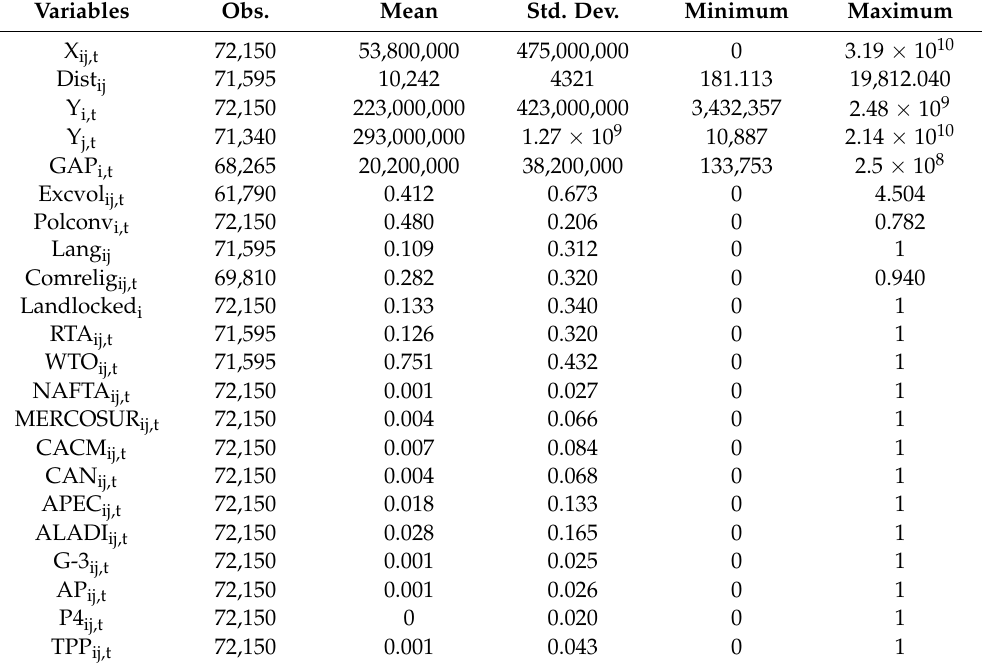
Table 1. Statistical Summary of the Variables.